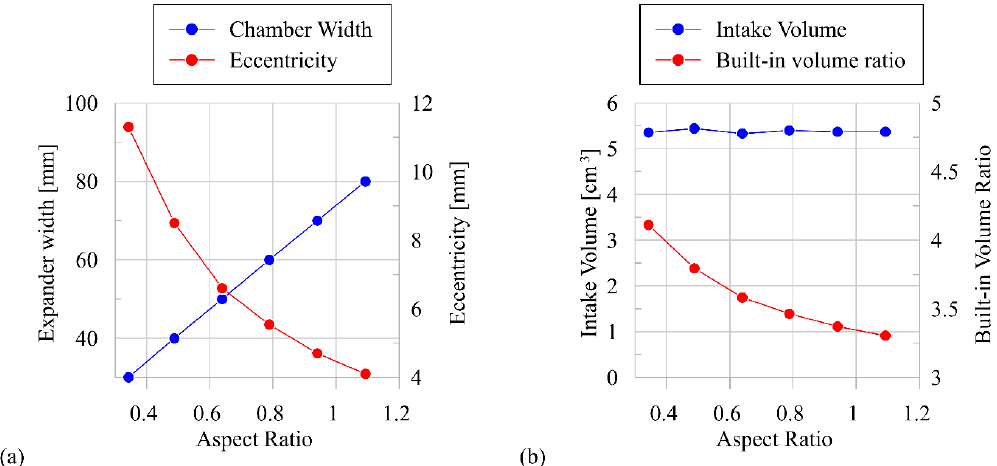
Figure 11. Results of the model-based design: ( a ) geometrical configuration; ( b ) built-in volume ratio.